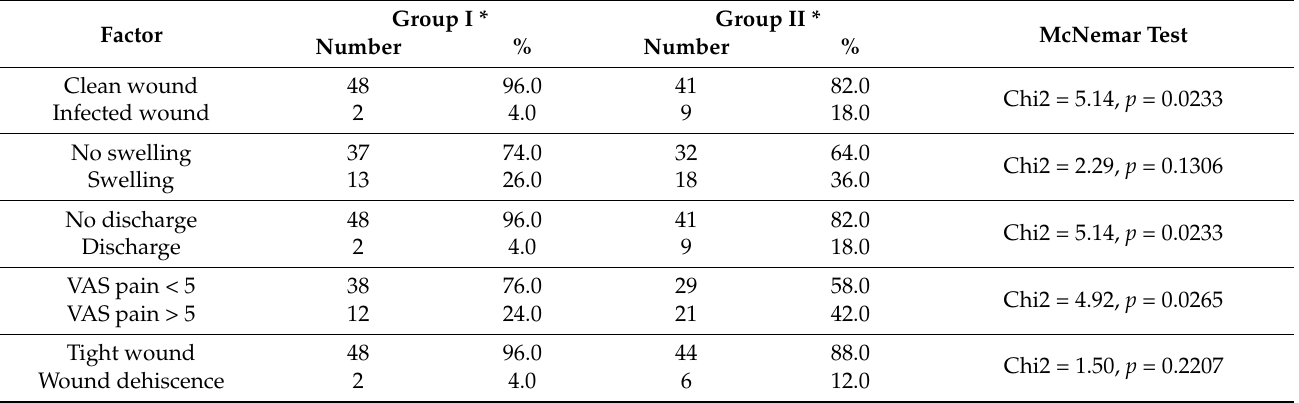
Table 2. Soft tissue healing assessment in the group of 50 patients performed on the 10th day post-extraction according to the ARSTH scoring scale.